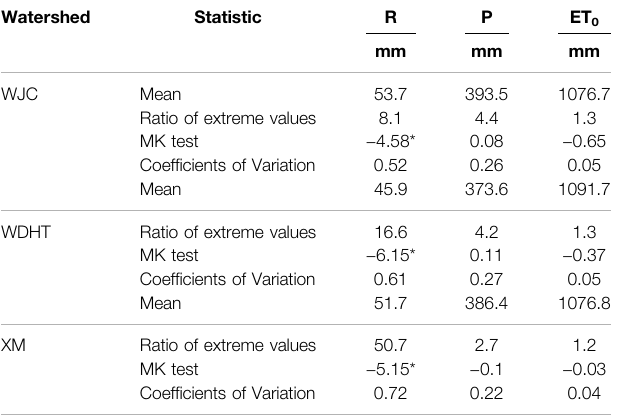
TABLE 1 | Variation of runoff depth (R), precipitation (P), and potential evapotranspiration (ET 0 ) for the Kuye River basin during 1960 – 2014. Watershed